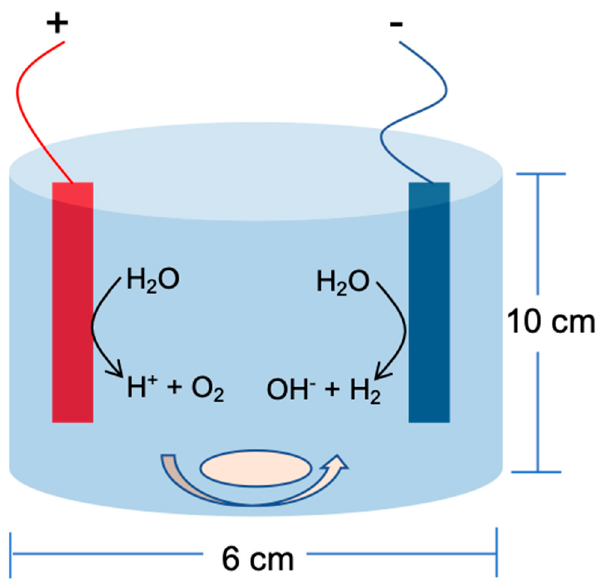
Figure 1. Configuration of the reactor for electro/Mn(II)/sulfite process. Reactor dimension was included, and reaction was under constant stirring. “+” and “ − ” denotes anode and cathode, respectively.